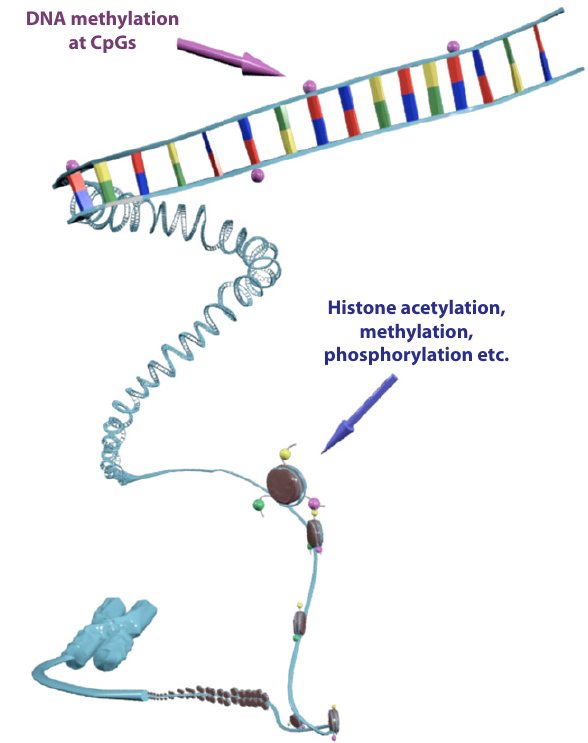
Figure 2. Epigenetic modifications are located on the chromatin and regulate transcriptional activity. DNA methylation at CpG nucleotides triggers chromatin remodeling, ultimately resulting in gene silencing, which is often associated with disease pathogenesis. Histone modifications such as acetylation, methylation, phosphorylationetc.co-determinethetranscriptionalstatusoftherespectivegenomicregion,holdingacritical role in various cell